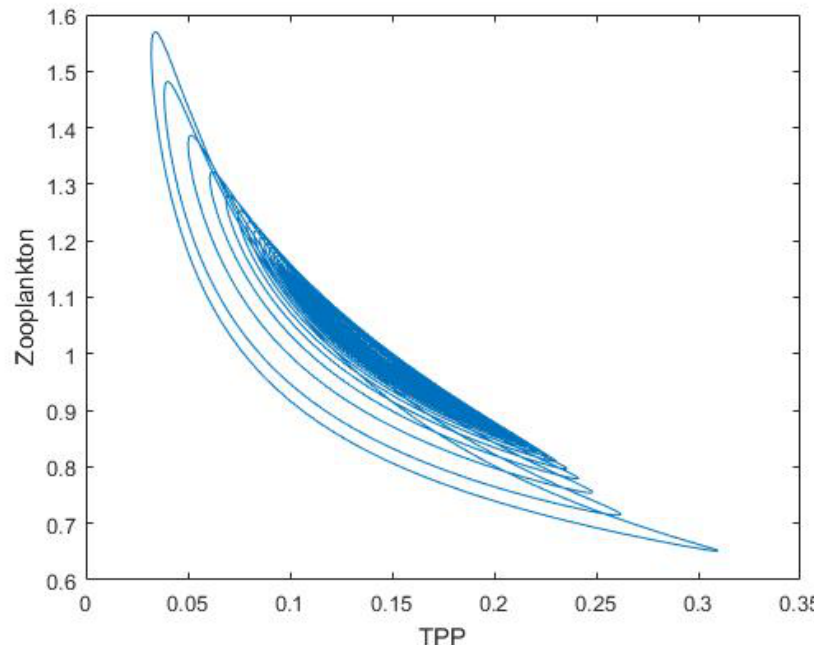
Figure 11. Equilibrium between the TPP and zooplankton populations loses its stability for τ < τ 0